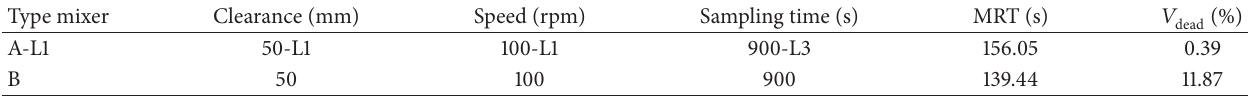
Table 6: Parameter setting and results obtained from confirmation